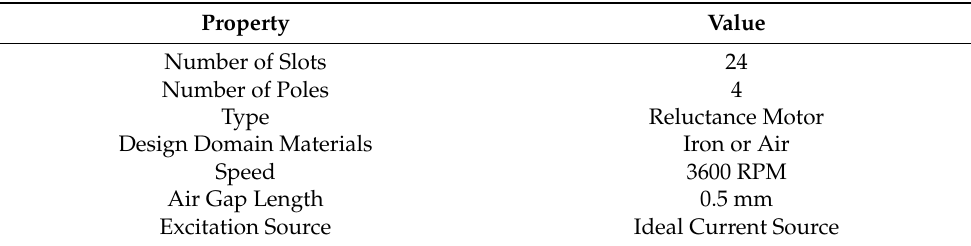
Table 1. Specification of reluctance motor.